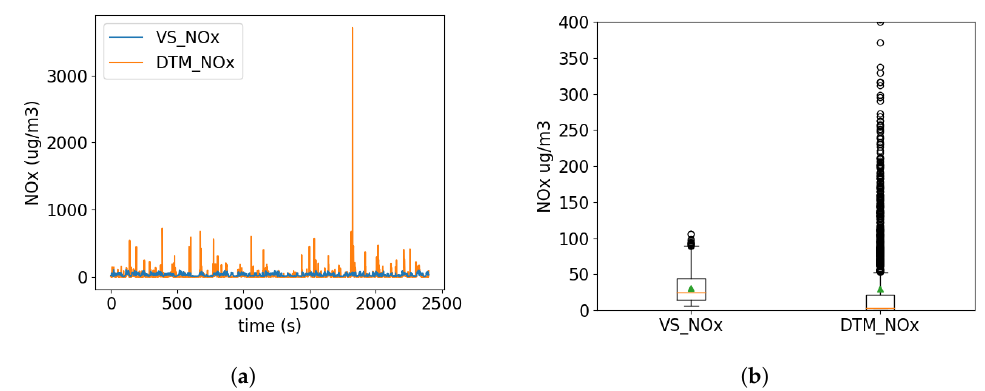
Figure 11. LES concentrations for volume source and dynamic traffic model for Day 2 at location of CAPS sensor. ( a ) Day 2 time series (1 s resolution) and ( b ) Day 2 box plot (1 s resolution).